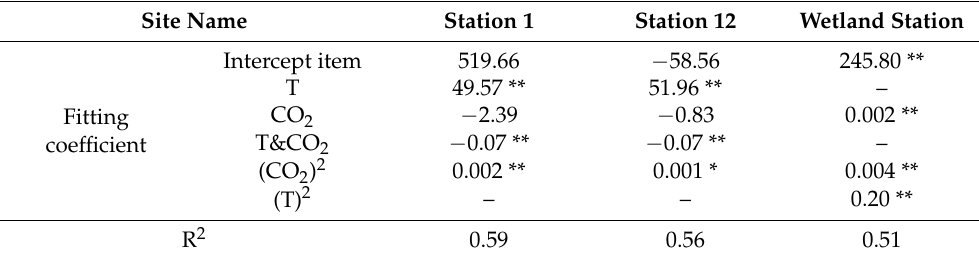
Table 4. The multiple regression analysis of temperature and CO 2 on LE under different underlying surface